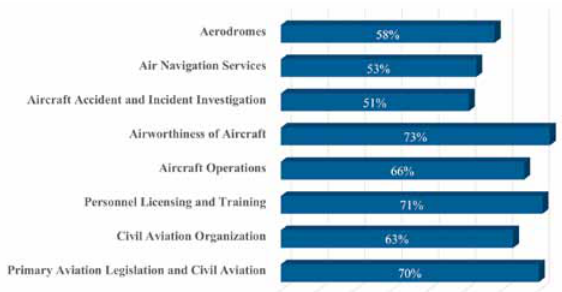
Fig. 1. Global USOAP Audit Results, Effective Implementation of Safety Oversight according to Technical Area in 2012 (adapted from ICAO 2013) The European Union (EU) common